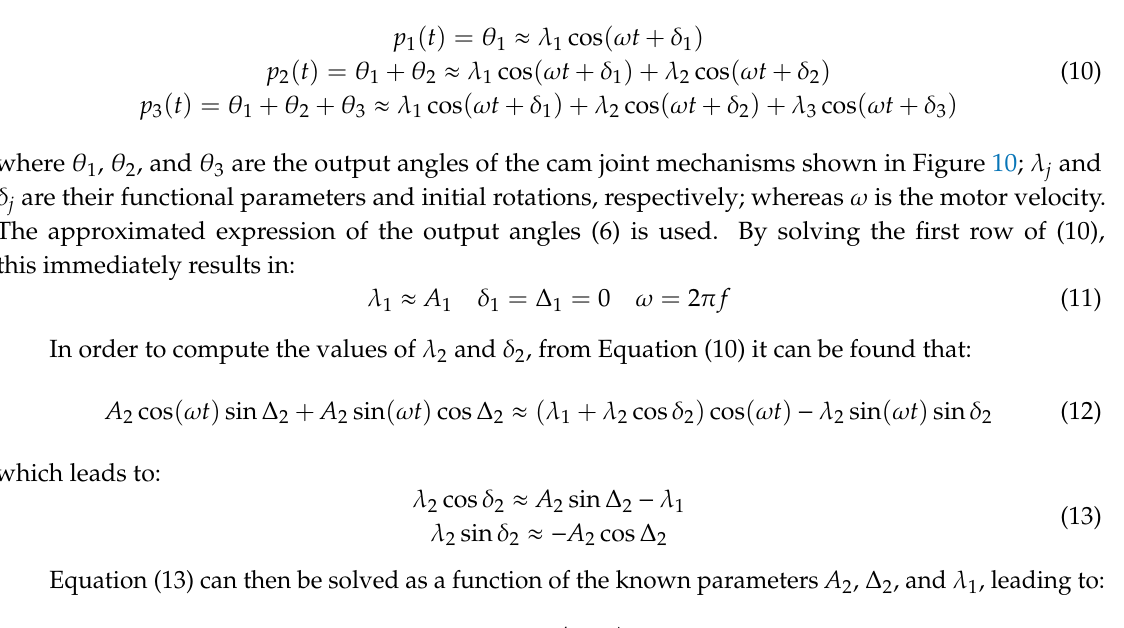
Figure 11. ( a ) Double Cardan joint: unbent tail (left), bent tail (right). ( b ) Spatial cam joint geometry.